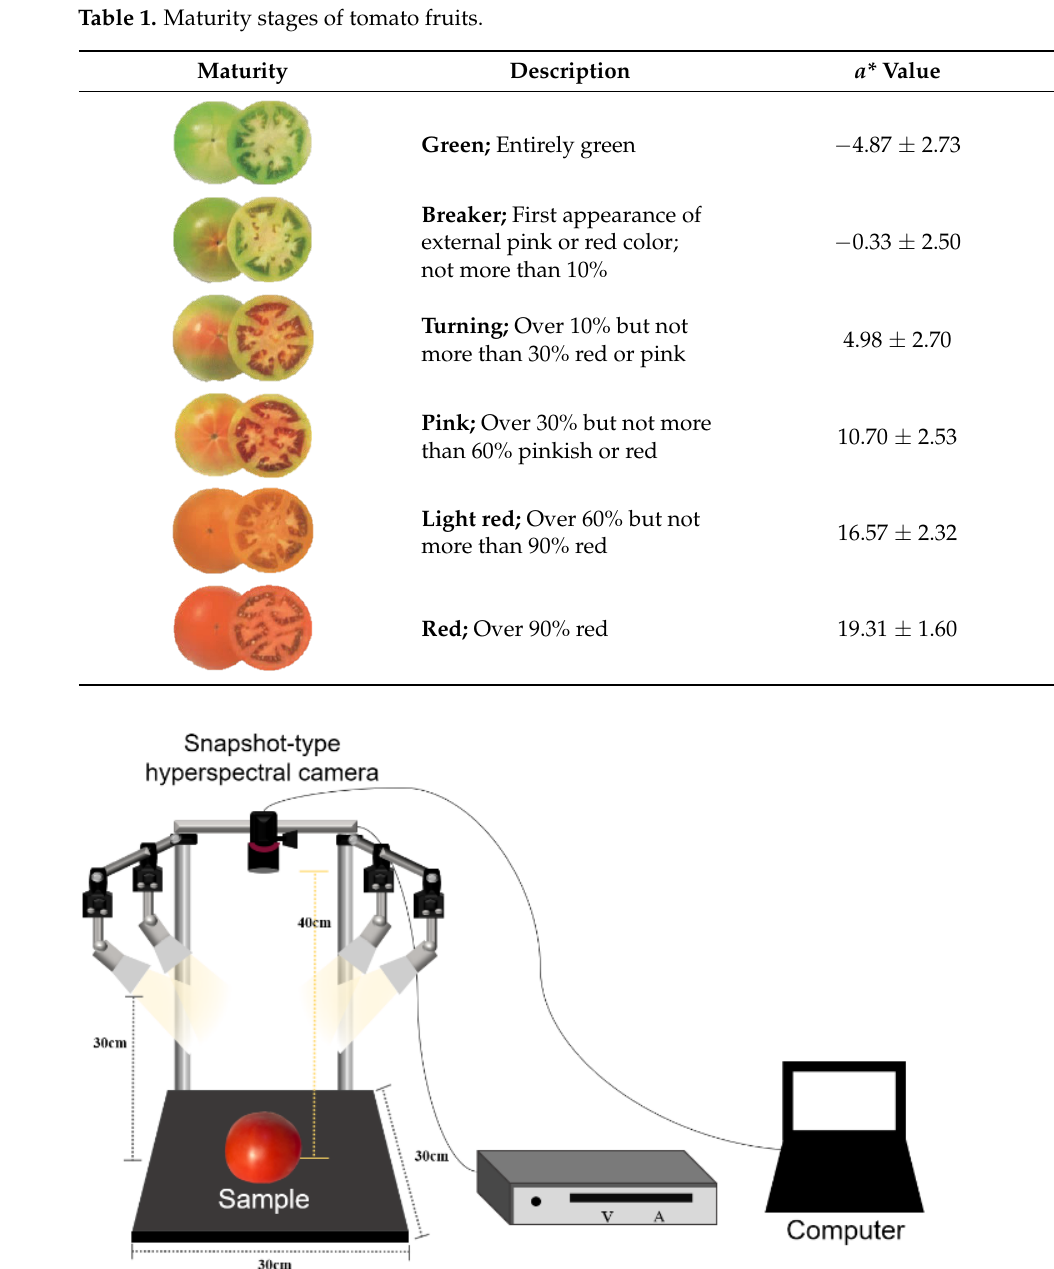
Table 1. Maturity stages of tomato fruits.